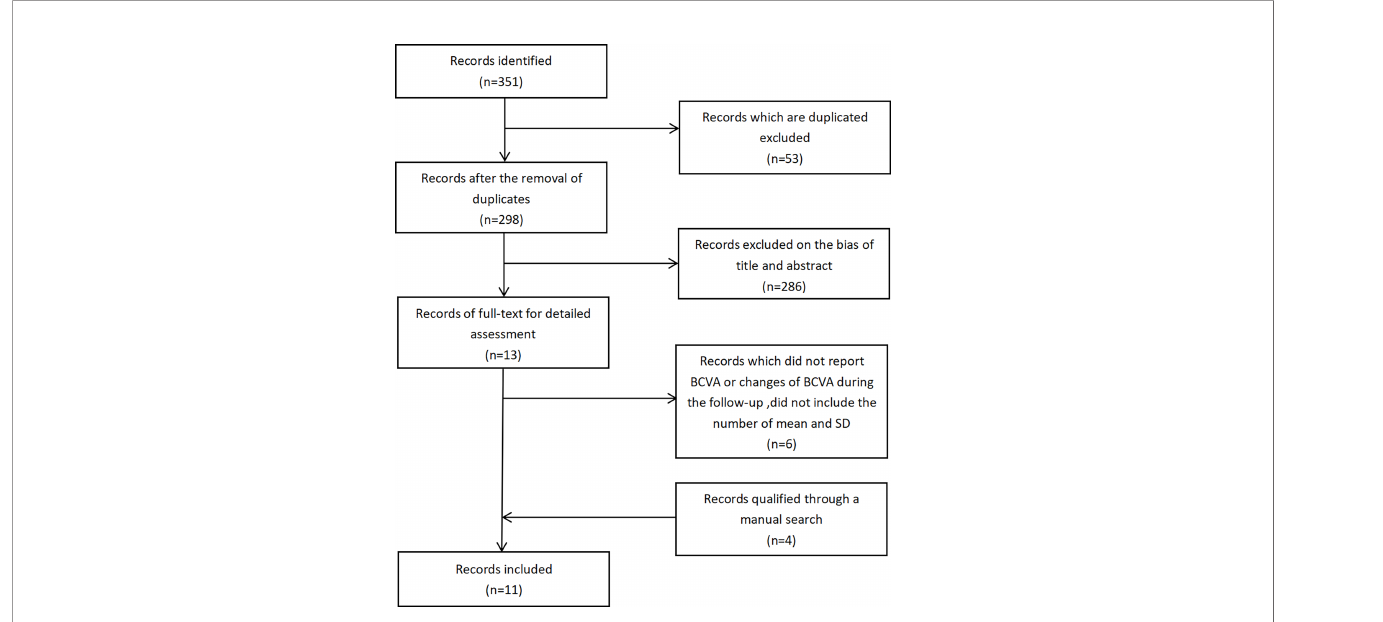
FIGURE 1 | Process of study